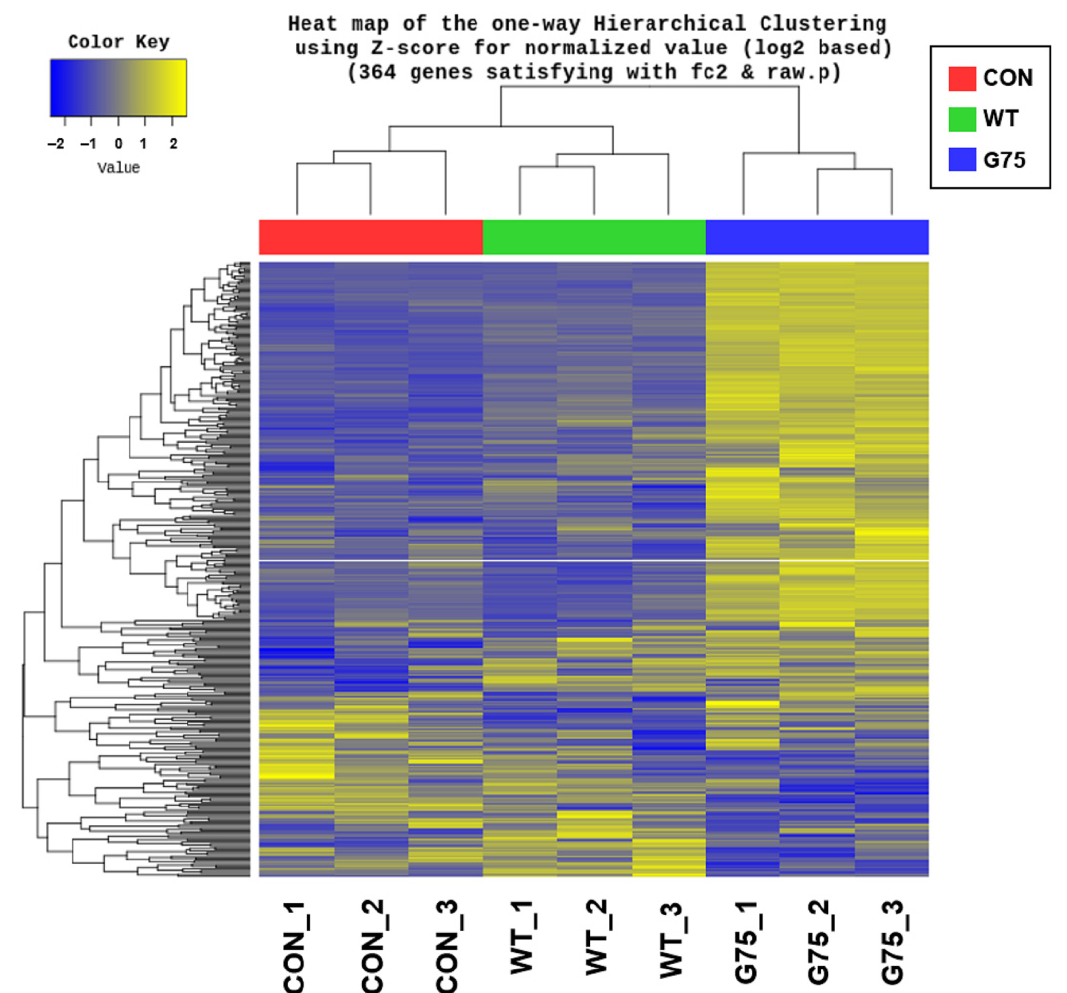
Figure 3. Hierarchical clustering of differentially expressed genes (DEGs) in Caco-2 cells unstimulated (CON) and stimulated by wild-type spores (WT) or CotG-p75 (G75). Each row represents one of the common genes. Each column represents each sample. The color scale shows the gene expression standard deviations from the mean represented as Z-score, with yellow indicating up-regulation and blue indicating down-regulation.